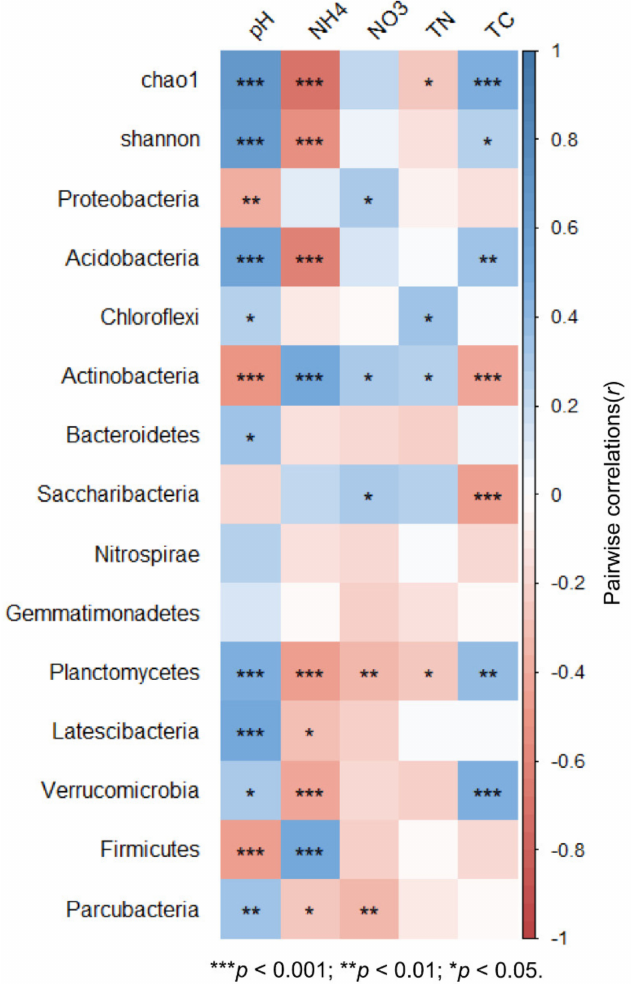
Figure 5. Pairwise correlations of bacterial diversity indices and abundant phyla (relative abundance >1%) with soil properties. The Pearson correlation coefficient was used to test the relationships between soil properties and alpha diversity indexes. Spearman correlation coefficients were utilized to assess the correlations between soil properties and bacterial main